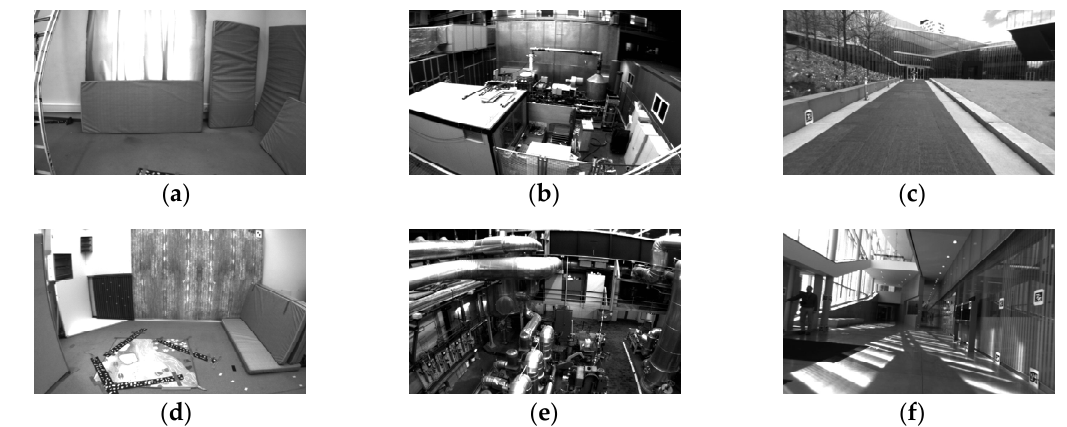
Figure 5. EuRoc MAV datasets and PennCOSYVIO dataset scenes. Images ( a , d ) are the room scenes of the V1_01_easy dataset in the EuRoc MAV datasets. Images ( b , e ) are the machine hall scenes of the MH_05_difficult dataset in the EuRoc MAV datasets. Images ( c , f ) are the indoor and outdoor scenes of PennCOSYVIO dataset.